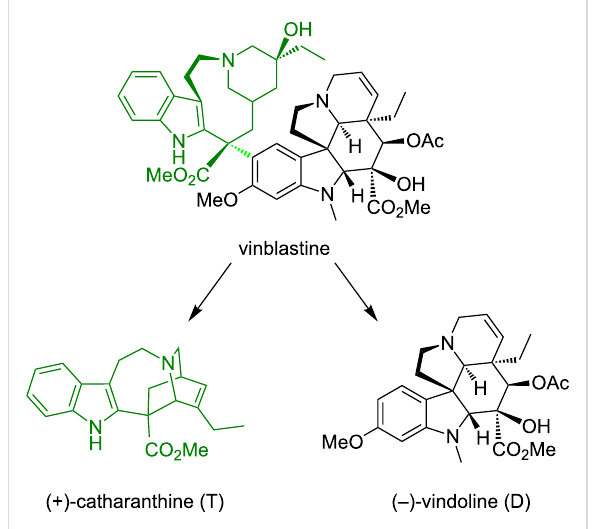
Figure 4: Catharanthine and vindoline, monomers constituting the anticancer vinblastine and the analogous vincristine.